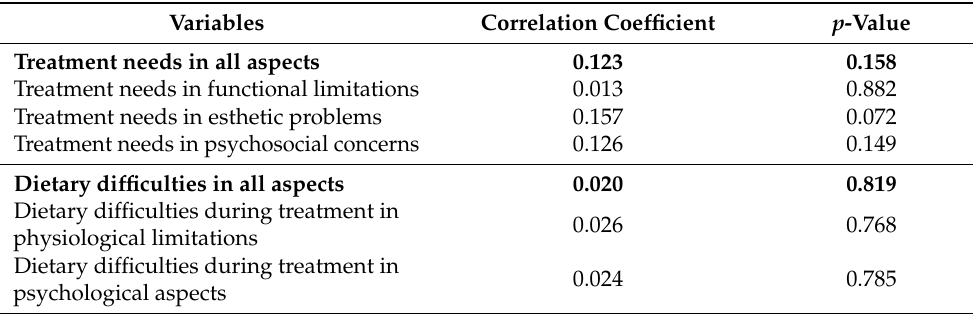
Table 5. Correlations of OHRQoL perceived by the patients and evaluated by their orthodontic postgraduates.